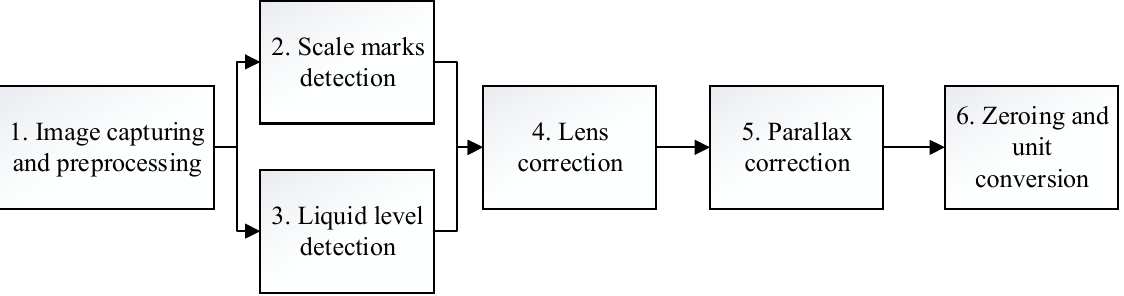
Figure 7. Operational diagram of the computer program .